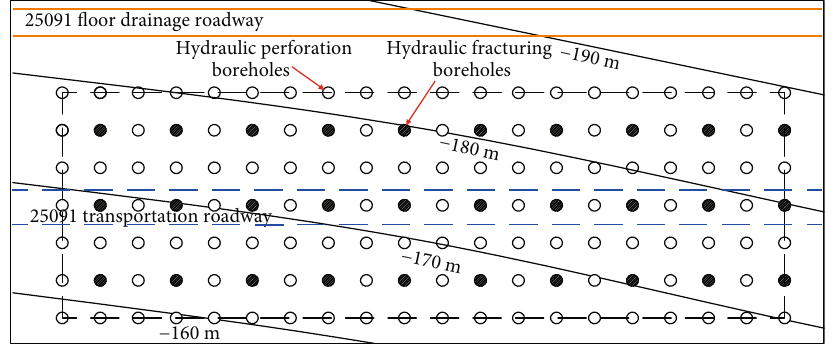
Figure 14: The layout of the hydraulic perforation and hydraulic fracturing boreholes.